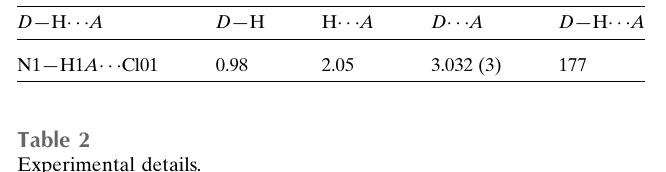
Table 2 Experimental details.